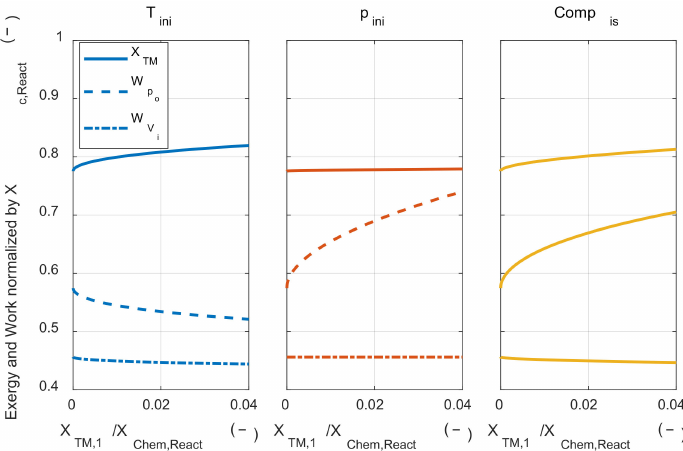
Figure 10. The exergy conversion, the system’s net work, and work that is obtained by expanding to the initial volume under the various thermodynamic state changing